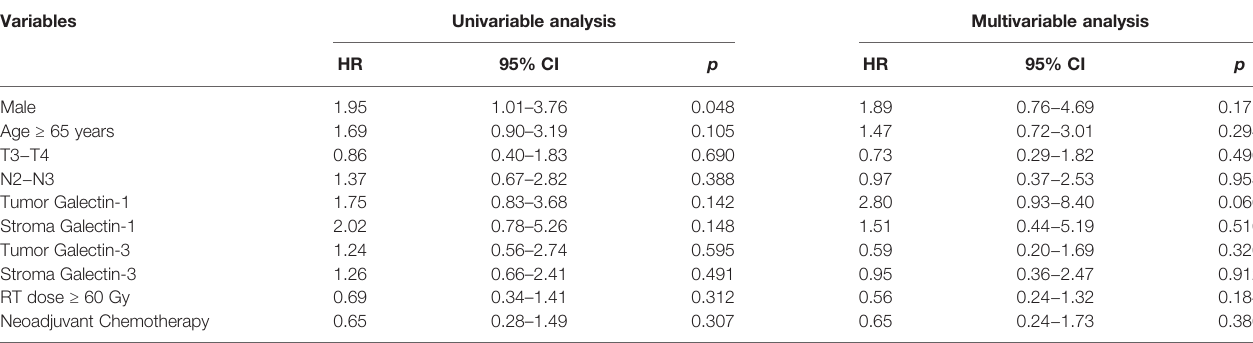
TABLE 2 | Univariable and multivariable Cox regression analyses of OS. Variables Univariable analysis